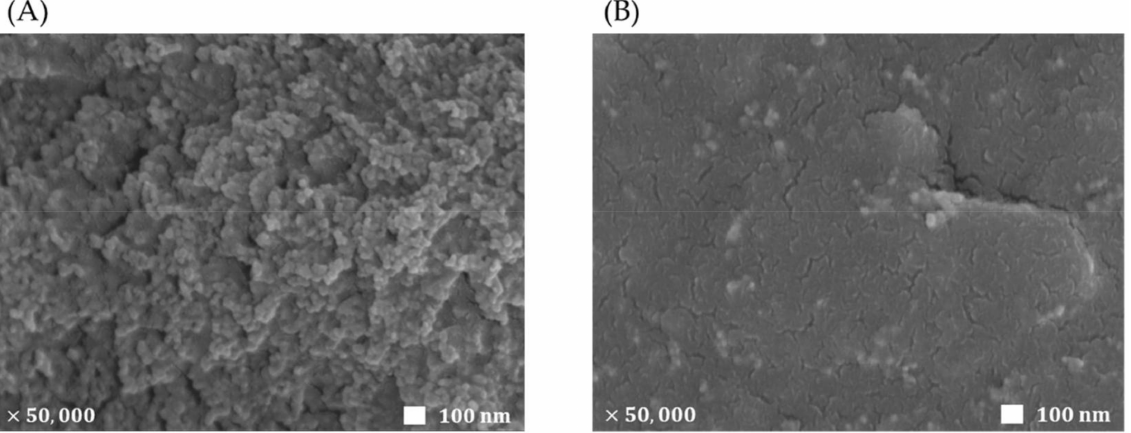
Figure 1. SEM images of one-step prepared ECL sensors based on titania-Nafion ( A ) and graphene- titania-Nafion ( B ) composite films (graphene: 1.25 mg/mL). White bars in figures are equivalent to 100